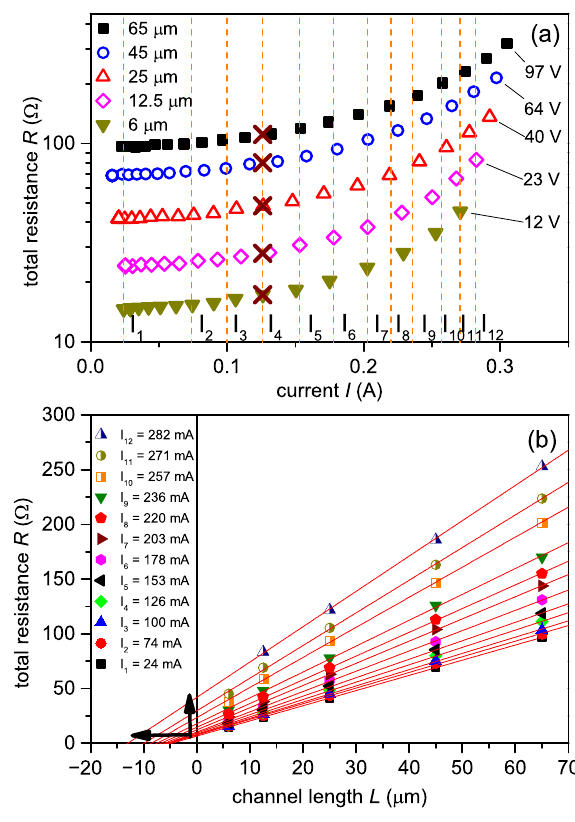
Figure 3. The dependence of the total resistance R on the current I for the different channel length L ( a ) and on channel length for a different current ( b ). L = 6 µ m (closed triangles), 12.5 µ m (open diamonds), 25 µ m (open triangles), 45 µ m (open circles) and 65 µ m (closed rectangles). The mea- surements are presented for the AlGaN/GaN channel. The resistance values at a given currents (represented by the vertical dashed lines) are obtained from a linear interpolation; for the particular current I = 126 mA those are indicated as crosses. The applied maximal voltage for each length channel is indicated in the right side of the figure. Interpolated values of different length channels are depicted in the ( b ) for each current and are used for the estimation of the current dependent contact resistance R c and L x (see interception with abscissa and ordinate axis in ( b )). Solid lines are linearly fit with Equation (1) and arrows show the direction of the increase in R c and L x . I = 24 mA, 74 mA, 100 mA, 126 mA, 153 mA, 178 mA, 203 mA, 220 mA, 236 mA, 257 mA, 271 mA and 282